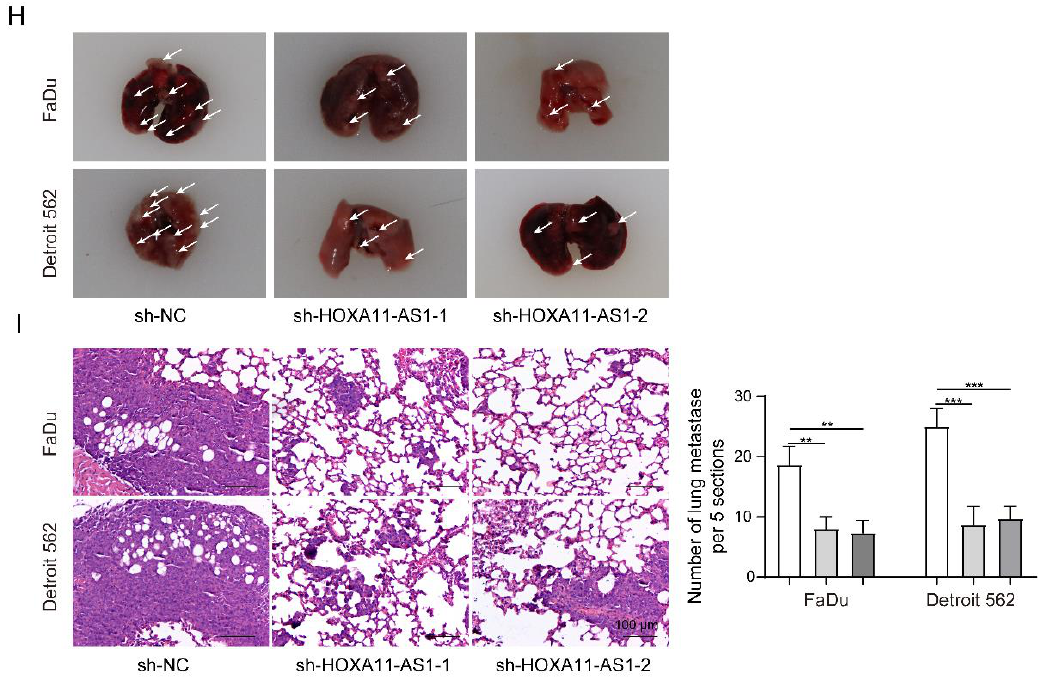
Figure 6. HOXA11-AS1 knockdown inhibited immune escape and metastasis by regulating PD-L1 and downregulating FOSL1 in vivo. FaDu and Detroit cells stably expressing shNC, shHOXA11-AS1-1, or shHOXA11-AS1-2 were injected subcutaneously into NOD-SCID mice to establish xenograft models. PBS or PBMCs were intraperitoneally injected into NOD-SCID mice to kill the xenografts more effectively. ( A ) HE, Ki67, and IHC staining were used to measure the tumor pathology, proliferation, and PD-L1 expression of xenografts treated with or without PBMCs or PBC. ( B ) The percentage of Ki67 cells was evaluated in xenografts. ( C ) The cytotoxic effect of treatment with or without PBMCs or PBS was measured by calculating xenograft volumes in shNC, shHOXA11-AS1-1, and shHOXA11-AS1-2 xenografts, and results are shown in the bar chart as tumor regression rate. ( D – F ) Tumor volume and weight were detected after HOXA11-AS1 knockdown in vivo. ( G ) RT-qPCR was used to detect HOXA11-AS levels, and Western blot was used to measure the expression of PD-L1, FOSL1, and PTBP1 after HOXA11-AS1 knockdown. ( H – I ) The ability of metastasis to the lung, tumor pathology, and nodule numbers of lung metastases were measured after of HOXA11-AS1 knockdown. * p < 0.05, ** p < 0.01, *** p < 0.001. Original Blots see Supplementary File